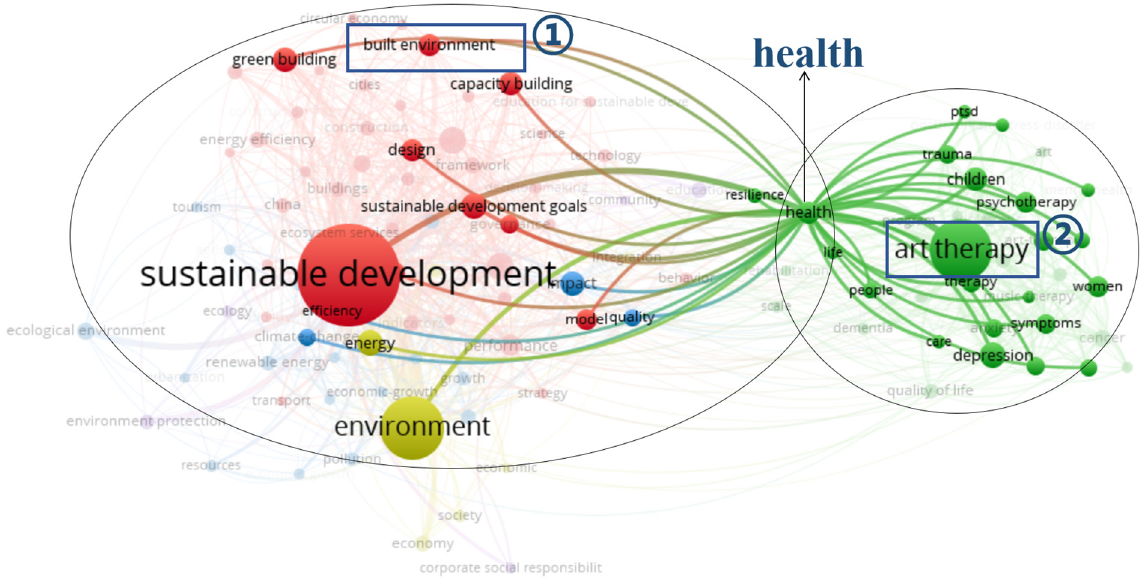
Figure 3. Network visualization map with the theme of health in the WoS core collection database via VOSviewer (devised by the authors).